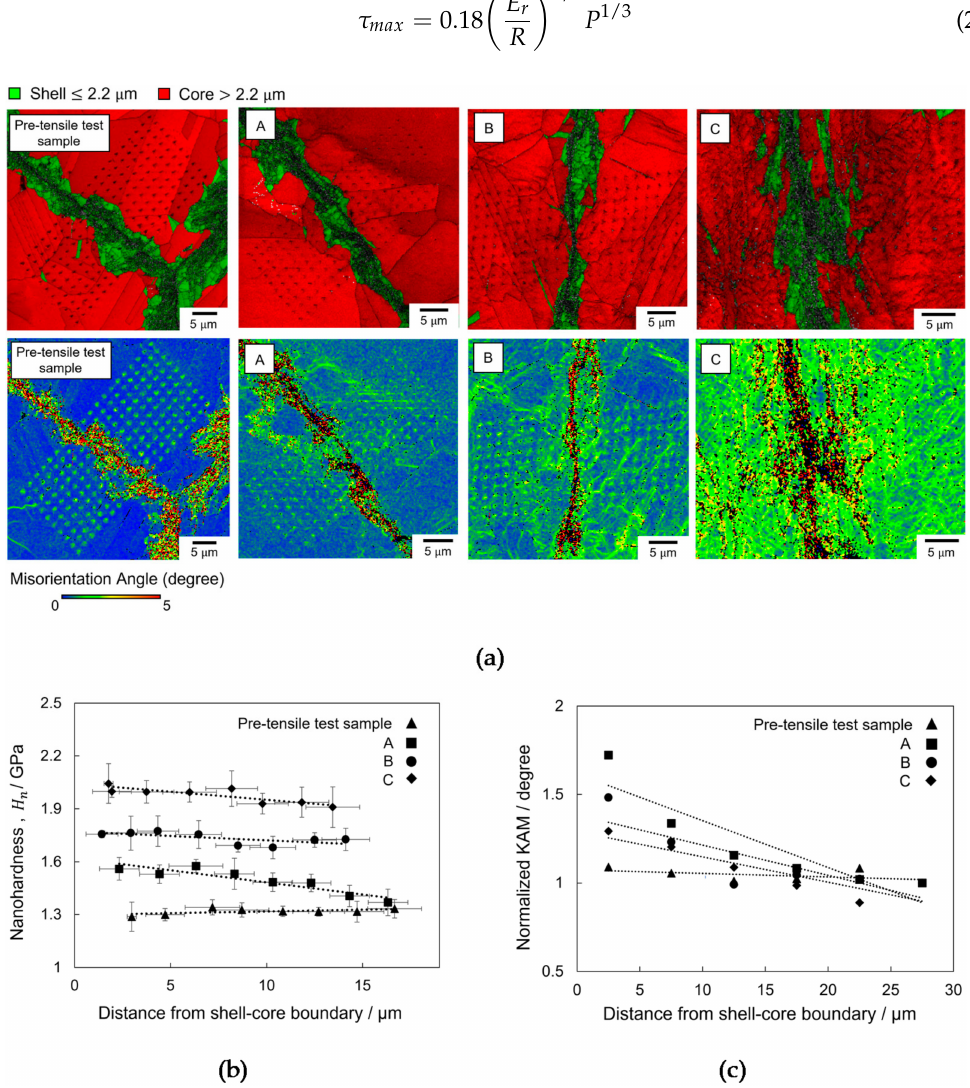
Figure 3. ( a ) IQ maps overlaid on the grain size (top) and KAM (bottom) maps with a 0.2 µ m step size at the nanoindentation area of the pre- and post-tensile test samples. The arrayed dots represent the nanoindentation marks. ( b ) Nanohardness of the pre-tensile test sample and three positions labeled as A, B and C on the post-tensile test sample plotted as a function of the distance from the shell–core boundary. ( c ) Normalized KAM as a function of distance from the shell–core boundary for the pre-tensile test and the three positions labeled as A, B and C on the post-tensile test